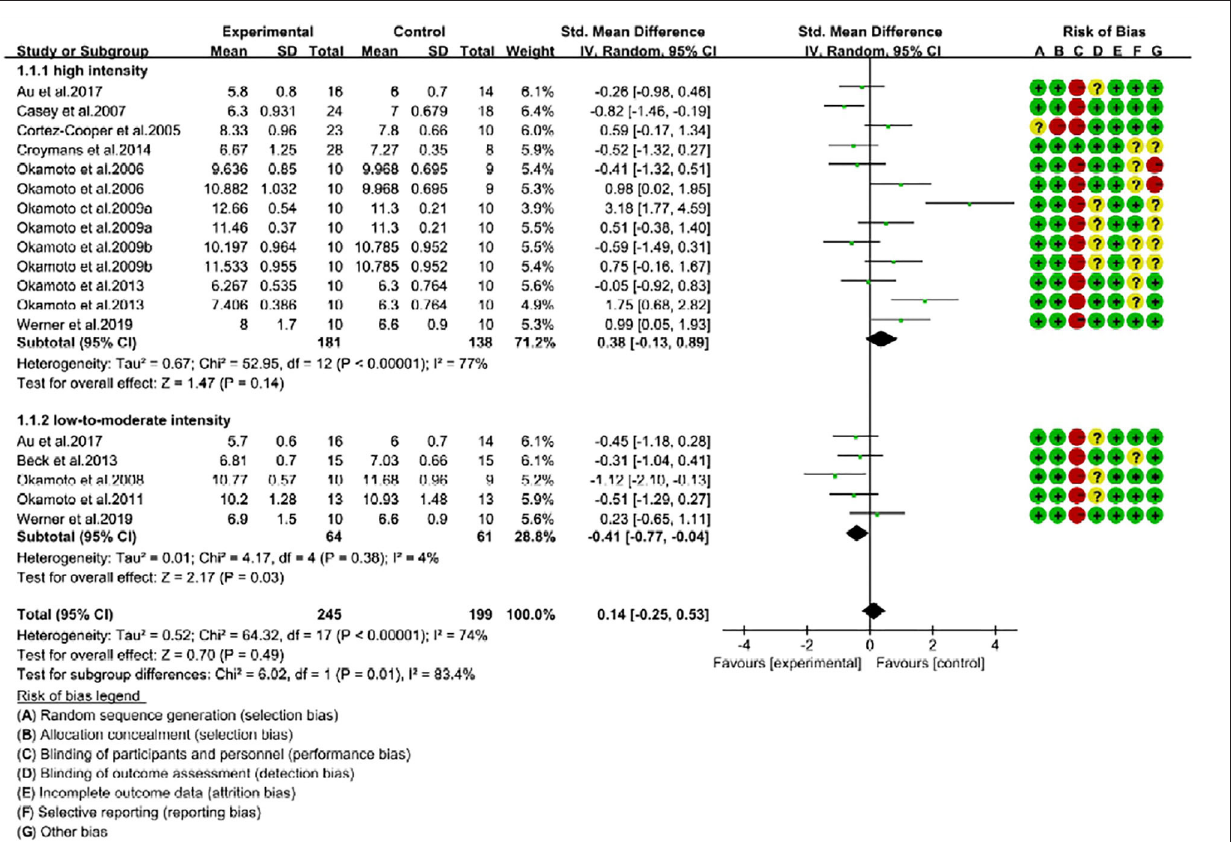
FIGURE 3 | Forest plot of pulse wave velocity (PWV) changes with different intensities of RE in young individuals (m/s). SD, standard deviation; IV, inverse variation; CI, confidence interval; df, degrees of freedom. Risk of bias: green ( + ) indicates low risk of bias; red (–) high risk of bias; and yellow (?) unclear risk of bias.